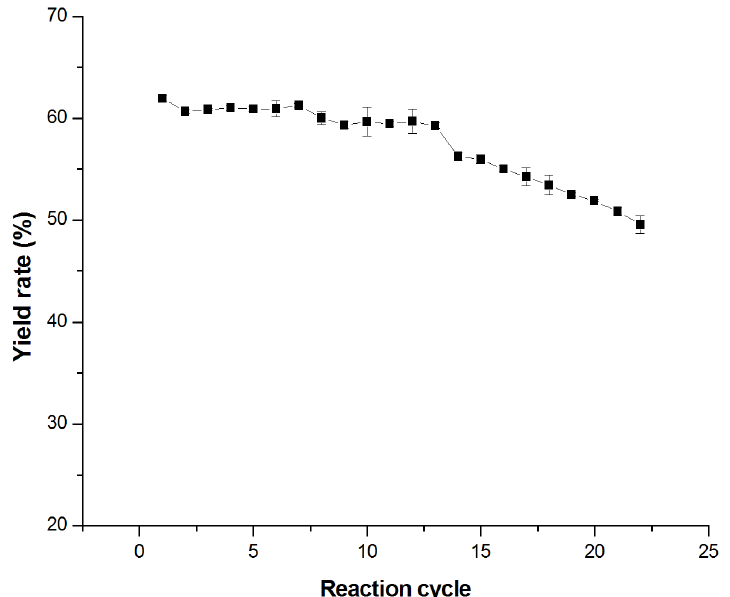
Figure 4. The reaction cycles of immobilized TtTreS. The reusability of immobilized TtTreS was evaluated by consecutive trehalose production cycles; 1 h represents 1 cycle. The data represent the mean values and standard deviations of three independent experiments.